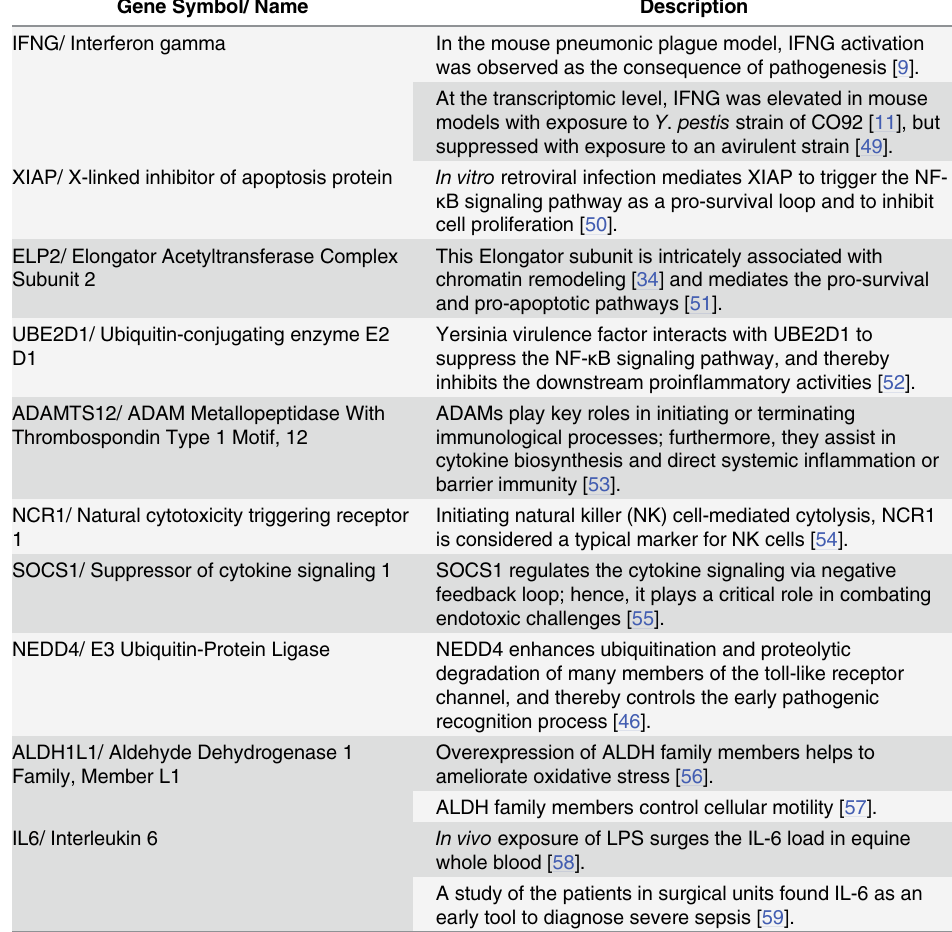
Table 1. A brief literature survey underlining the relevance of the genomic pool selected for